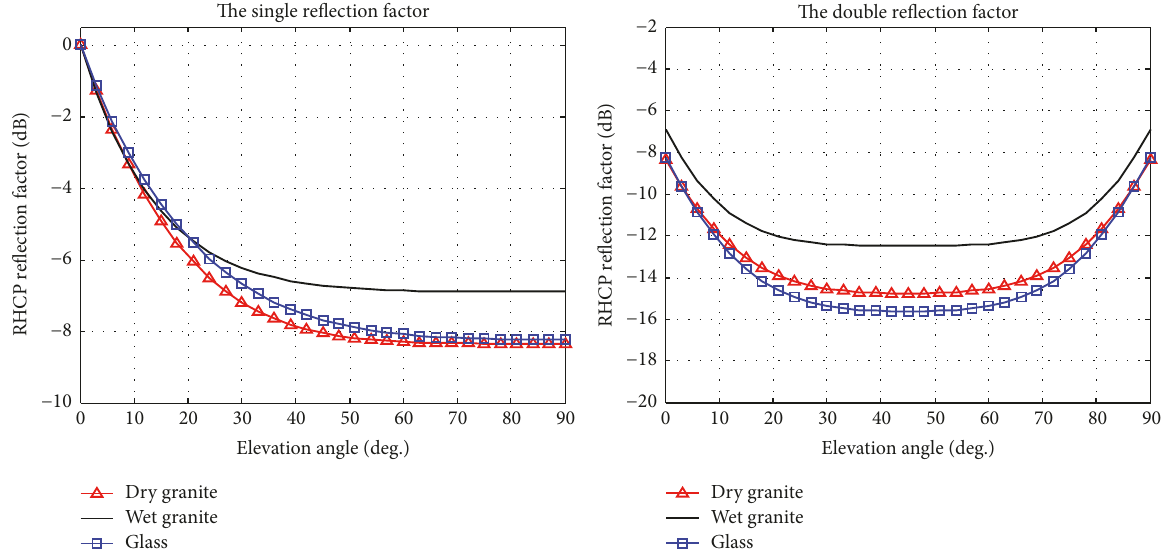
Figure 2: The reflection factor of NLOS signal when the LOS signal is